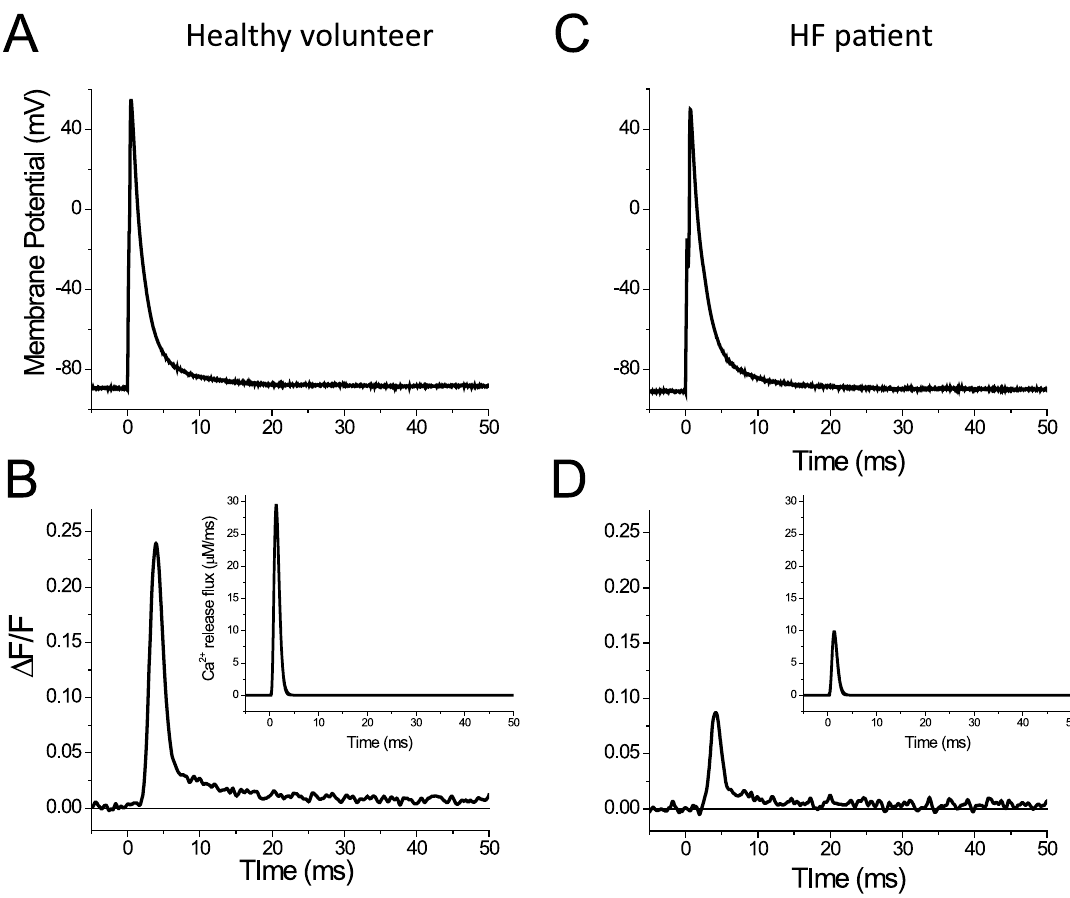
Figure 3. AP evoked Ca 2 + transients in fibers dissected from a healthy volunteer and a HF patient. Figures A and C are the APs and panels B and D are the corresponding Ca 2 + transients. The insets in B and D are Ca 2 + release fluxes (in m M/ms) calculated from the corresponding optical records. The fibers were equilibrated with an internal solution containing 30:15 EGTA:Ca 2 + .